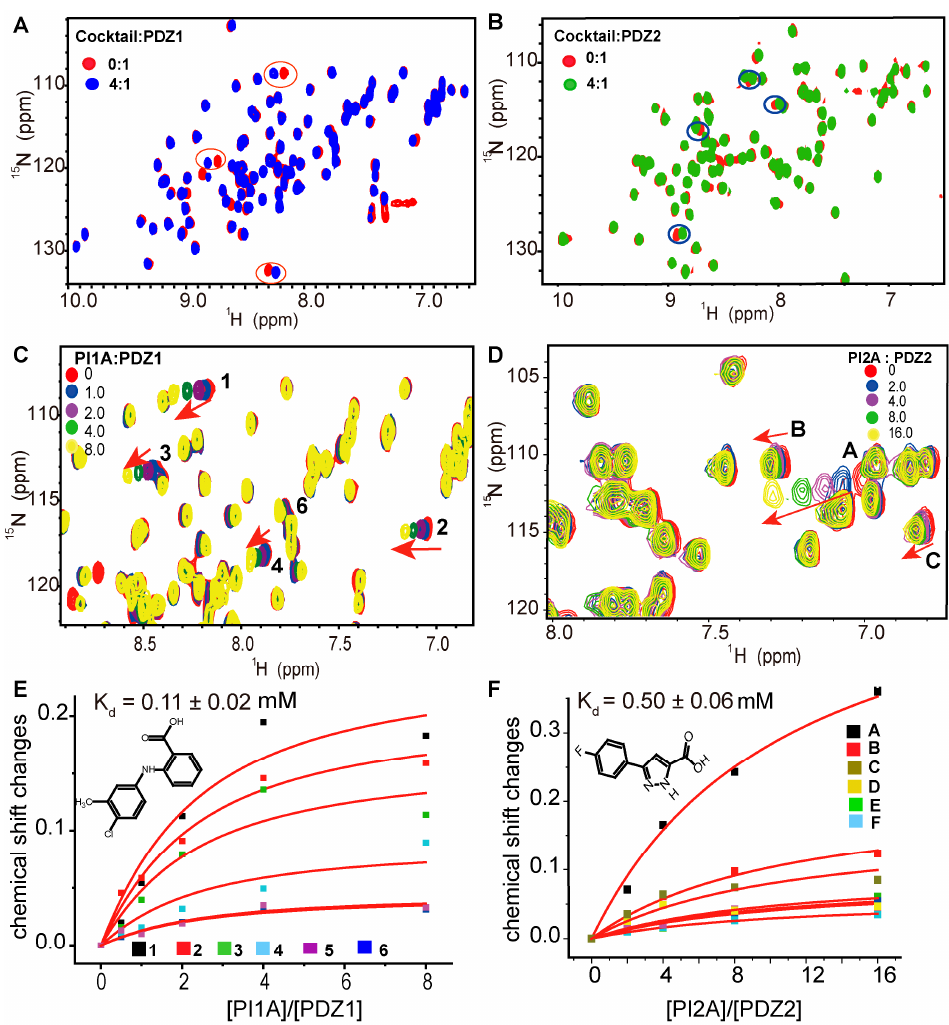
Figure 1. Fragment-based screening against the PDZ1 and PDZ2 domains of MDA-9. ( A ) Superimposition of the 1 H- 15 N heteronuclear single quantum coherence (HSQC) spectra of MDA-9 PDZ1 domain upon the addition of the compound cocktail. Ligand/protein molar ratios are annotated. ( B ) Superimposed HSQC spectra of MDA-9 PDZ2 domain. ( C ) Chemical shift perturbations of MDA-9 PDZ1 domain induced by PI1A. ( D ) The 1 H- 15 N HSQC spectra of MDA-9 PDZ2 domain upon titration of PI2A. Upon titrating PI1A and PI2A to MDA-9 PDZ1 and PDZ2 domain, respectively, some of these perturbed residues are zoomed in the boxed regions ( C , D ), where arrows are marked to indicate the trend of the chemical shift changes. The perturbed residues of MDA-9 PDZ1 domain were denoted by numbers and the perturbed residues of MDA-9 PDZ2 domain were denoted by letters. ( E ) The binding affinity of PI1A is determined by best fitting of the dose-dependent CSPs of MDA-9 PDZ1 domain. ( F ) Determination of the binding affinity of PI2A to MDA-9 PDZ2 domain by CSPs. The red solid line represents the dose-dependent titration curve for each disturbed residue of MDA-9 PDZ1 and PDZ2 domains. The numbers 1–6 represent all perturbed residues of MDA-9 PDZ1 domain, while the letters A–F represent all perturbed residues of MDA-9 PDZ2 domain.